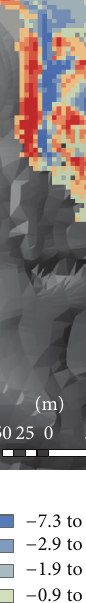
simulates wide spreading of the wave in the upper stream. This broad deposition did not occur in the real world event. Debris flow moves with the mean velocity of 3.5 m/s along